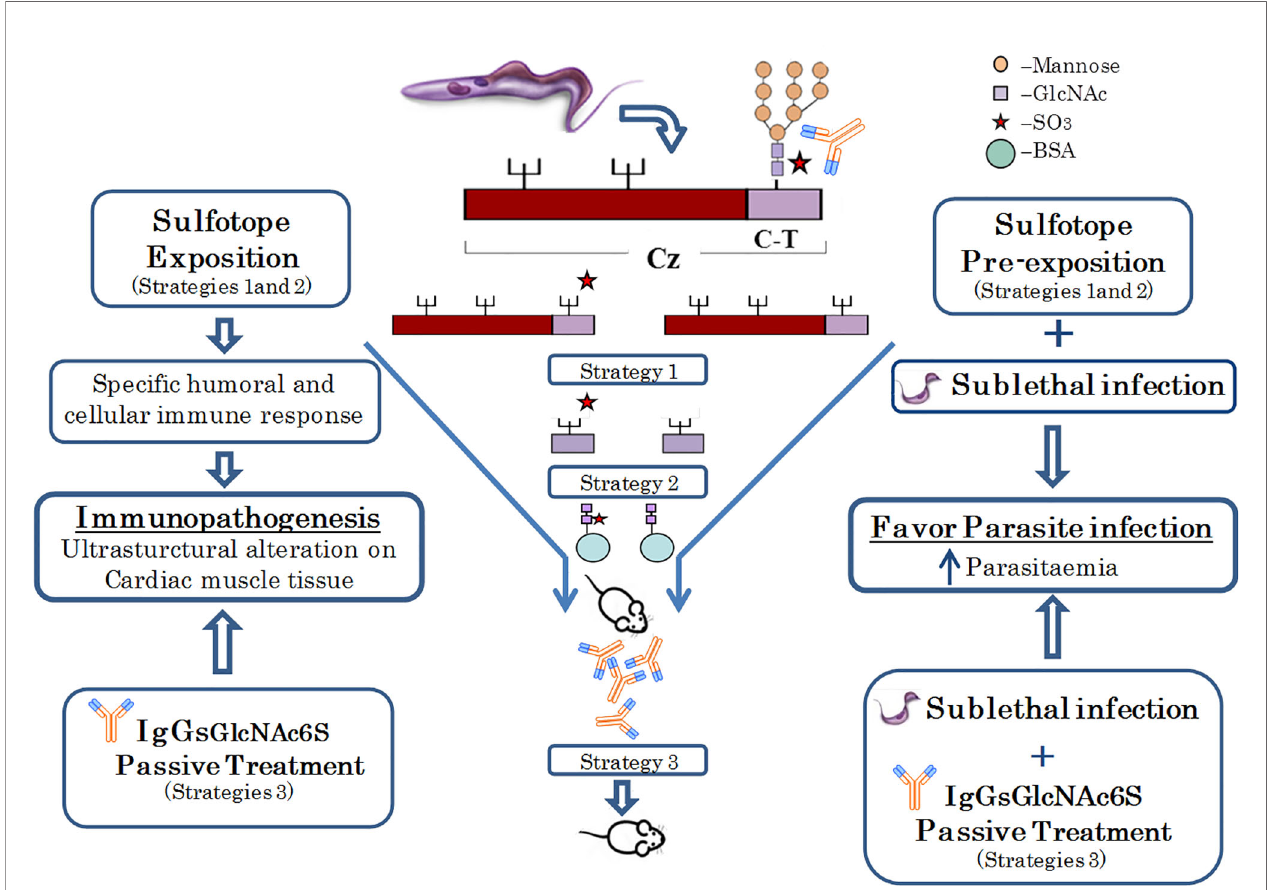
FIGURE 7 | Native Cz was obtained from T. cruzi ; C-T was puri fi ed from Cz. The immunogenic pairs Cz/dCz and C-T/dC-T were obtained by chemical desulfation process. The latter were used in strategy 1. In Strategy 2, the synthetic immunogens GlcNAc6S/GlcNAc coupled to BSA, as carrier proteins were used. Both strategies 1 and 2 evidenced both the humoral and cellular-speci fi c immune responses and the ultrastructural pathogenesis in the cardiac muscle tissue, after in vivo exposition to the sulfotope. In mice, pre-exposed to the sulfotope (strategies 1 and 2) and sublethally challenged, the infection showed to be favored, with elevated parasitemias. Finally, in strategy 3, passive treatment with antibodies obtained in strategy 2 was performed. This treatment has demonstrated that IgG-GlcNAc6S, by in vivo exposition, have generated ultrastructural alterations in heart tissue and the administration of IgG-GlcNAc6S postsublethal challenge favored parasitic infection. , mannose; ,